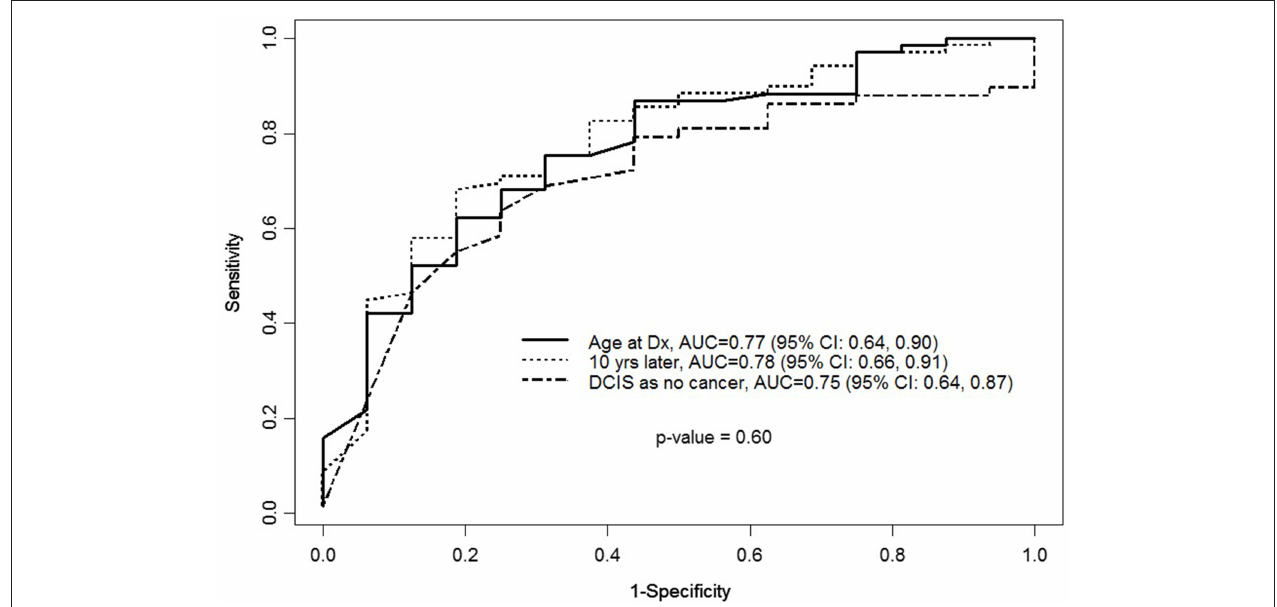
FIGURE 1 | ROC curve for BRCAPRO with age entered as age of diagnosis or age entered as 10 years older or with DCIS entered as not a cancer in the model when the outcome is BRCA